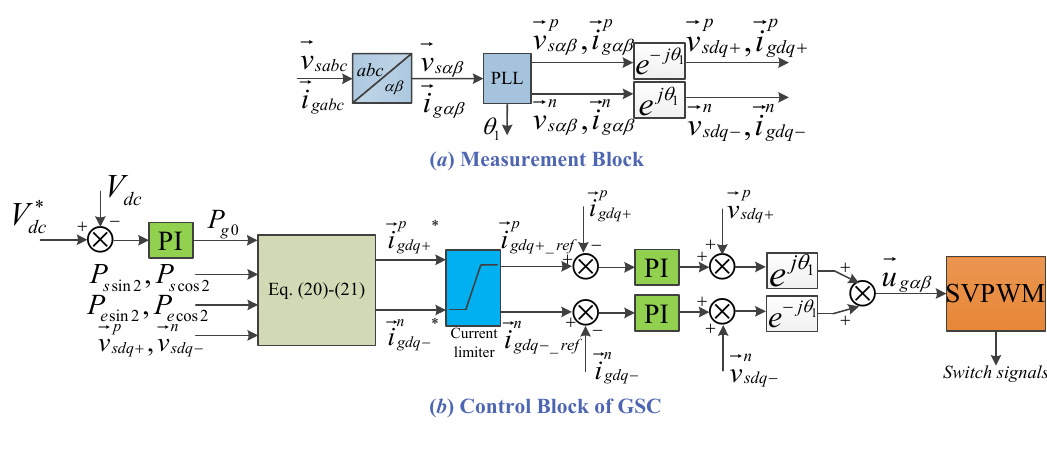
( b ) Control Block of